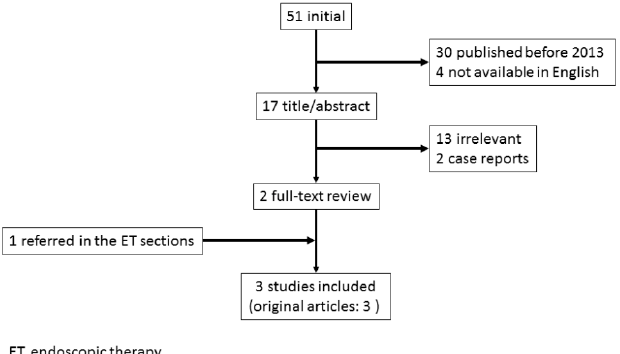
Figure 3. Study flow chart in transcatheter angiographic embolization for bleeding gastric cancer.